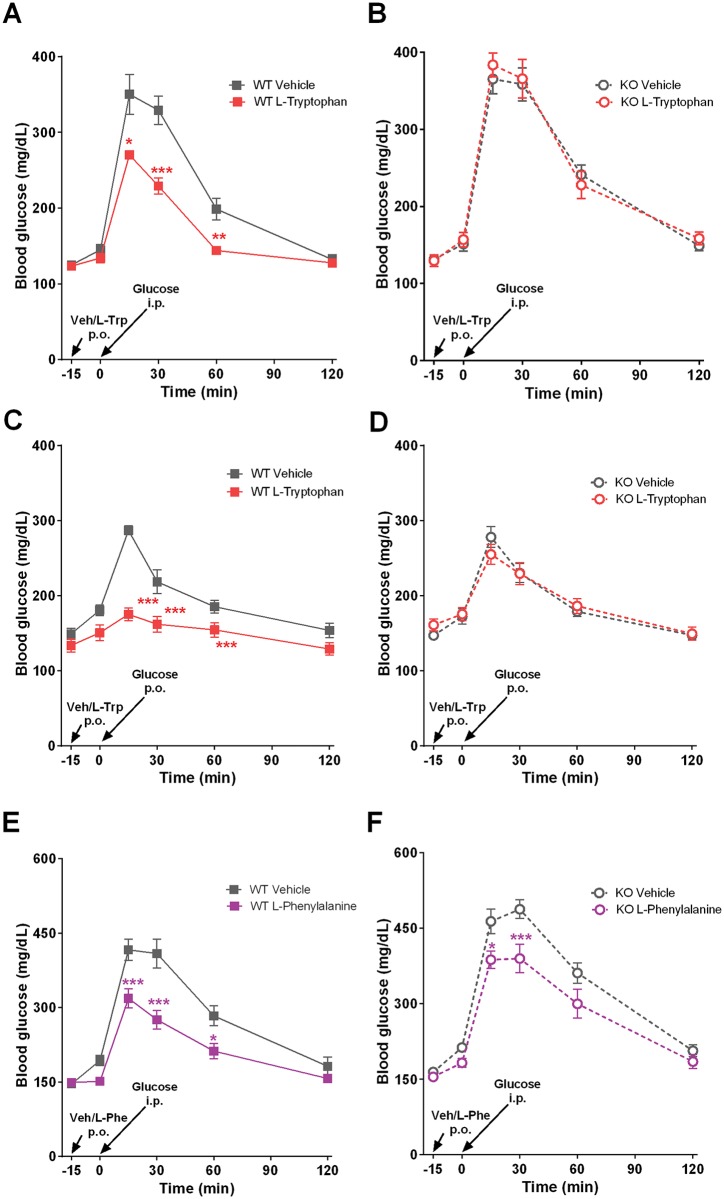
Glucose tolerance tests after L-Tryptophan and L-Phenylalanine oral dosing in Gpr142KO mice and WT littermate controls.(A-D) Vehicle (15% HP-β-CD) or L-Trp (500 mg/kg), or (E-F) vehicle or L-Phe (500 mg/kg) was dosed orally at 20 ml/kg to 5hr daytime fasted mice 15 minutes prior to the glucose challenge. Glucose (2 g/kg) was injected i.p. (A-B, E-F) or given by oral gavage (C-D) at indicated time points. Tail blood glucose was monitored for 120 minutes after glucose injection. Animals used were male, 5–8 months of age, and maintained on standard chow diet. Data are mean ± SEM. N = 7 per group. *,**,***: p<0.05, 0.01, 0.001 treatment group vs. vehicle.